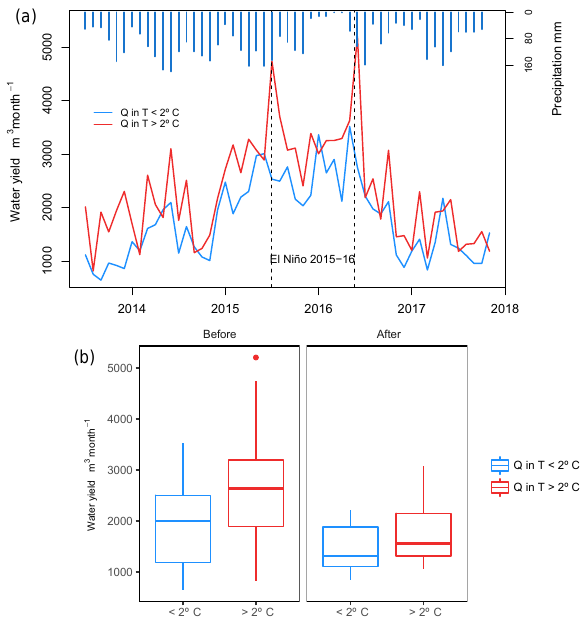
Figure 7. Mean monthly water discharge ( Q ), for days with tem- perature lower than 2 ◦ C (blue) and days with temperature higher than 2 ◦ C (red): (a) interannual evolution with indication of El Niño 2015–2016 event (grey shading), breakpoint in water discharge evo- lution (dashed line) and monthly precipitation (blue bars); (b) com- parative box plots for water discharge before and after breakpoint in May 2016.